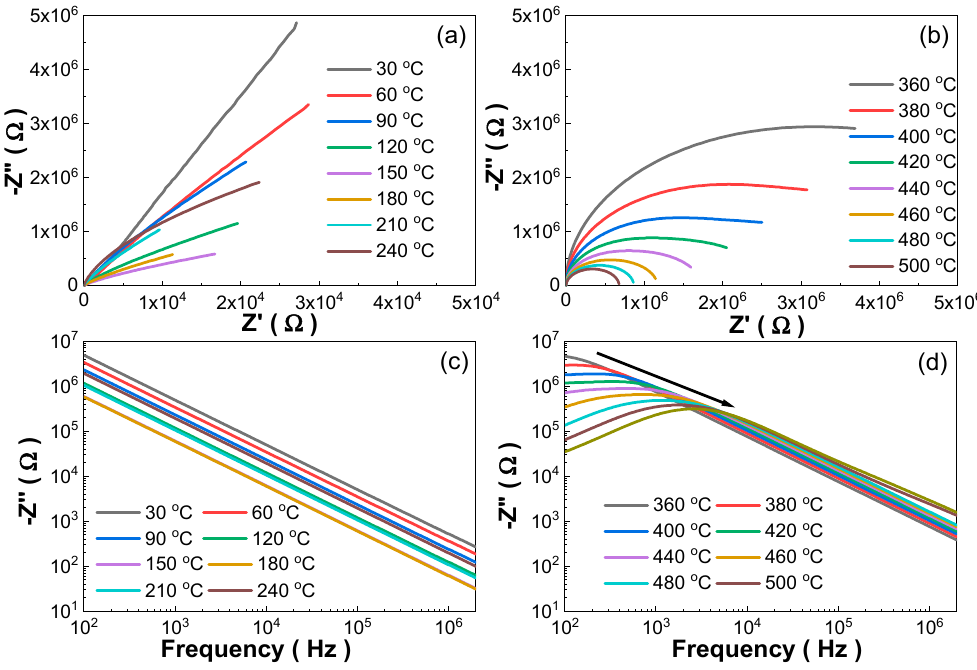
Figure 2. Complex impedance spectra of the as-grown Mn:PIMNT crystals measured from 100 Hz to 2 MHz at different temperatures: ( a , b ) imaginary parts (Z ″ ) versus real parts (Z ′ ) and ( c , d ) imaginary parts (Z ″ ) versus frequency.